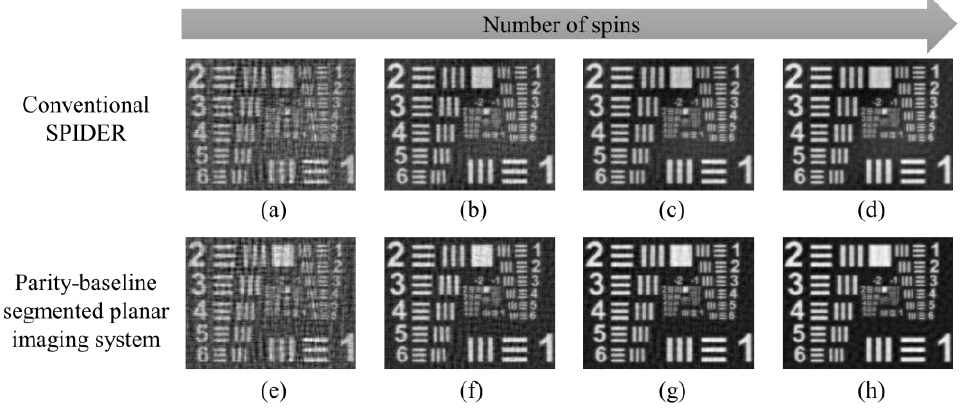
Figure 4. ( a – d ) Rotational imaging result of the conventional SPIDER with the number of spins of 1, 5, 10, 15. ( e – h ) Rotational imaging result of the parity-baseline segmented planar imaging system with the number of spins of 1, 5, 10, 15.